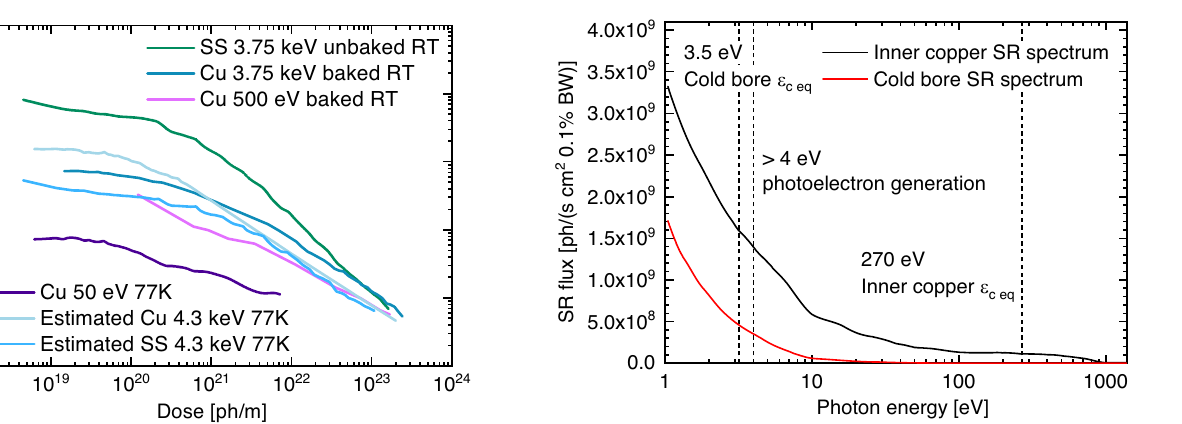
FIG. 4. H 2 equivalent molecular PSD yields ( η various common materials and conditions [28,29,35,36] compared with the estimated yields for the FCC-hh.